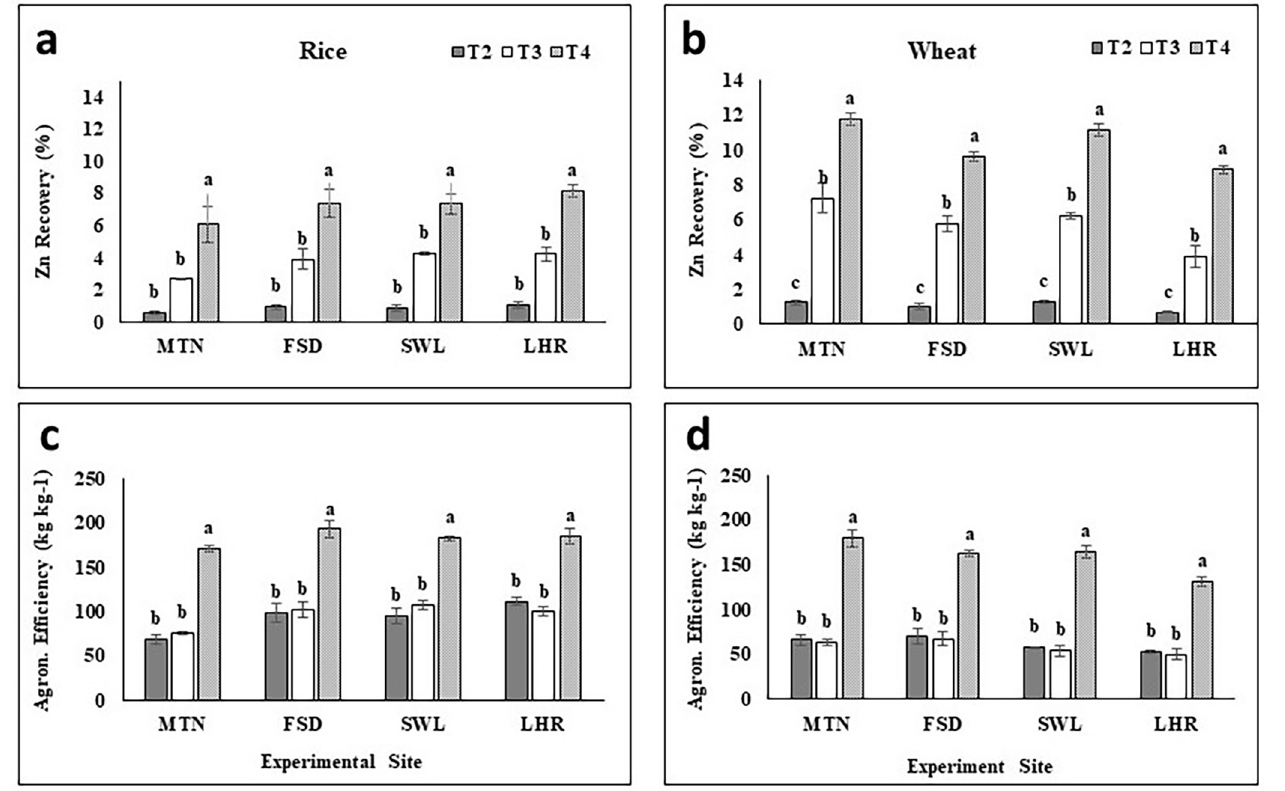
Fig 4. Effect of zinc sulfate and bioactive zinc coated urea on agronomic and Zn recovery efficiencies of rice and wheat. MTN = Multan; FSD = Faisalabad; SWL = Sahiwal; LHR = Lahore; BAZU = Bioactive Zn coated urea (42% N; 1% Zn); T 1 (Urea 46% N @ 185 kg ha -1 + zero Zn), T 2 (Urea 46% N @ 185 kg ha -1 + ZnSO 4 33% Zn @ 15 kg ha -1 ), T 3 (BAZU 42% N @ 100 kg ha -1 + Urea 46% N @ 62 kg ha -1 + 1% bioactive Zn @ 1.00 kg ha -1 ), T 4 (BAZU 42% N @ 125 kg ha -1 + Urea 46% N @ 62 kg ha -1 + 1% bioactive Zn @ 1.25 kg ha -1 ).